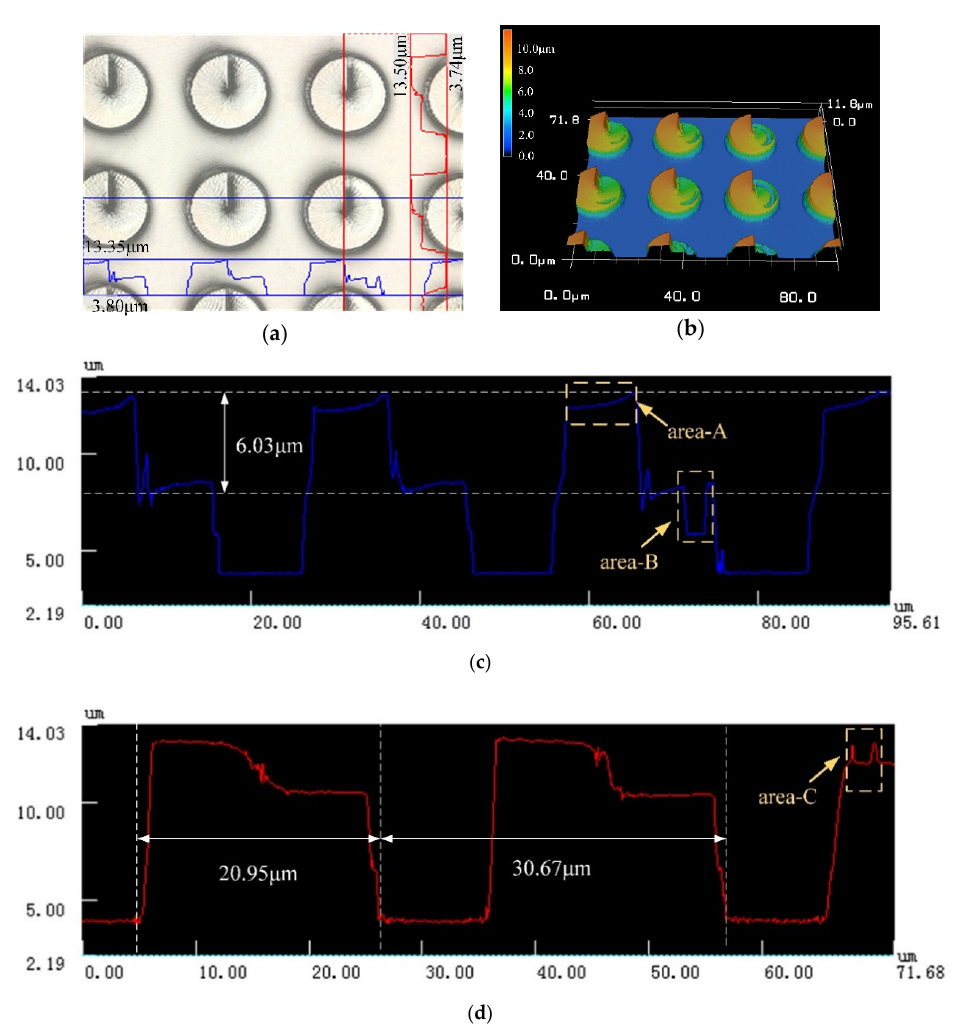
Figure 5. Appearance of a CSPA with a period of 25 μ m. ( a ) Two-dimensional topography and ( b ) three-dimensional topography and both the surface profiles indicating the height or depth by ( c ) and the featured horizontal size by ( d ).